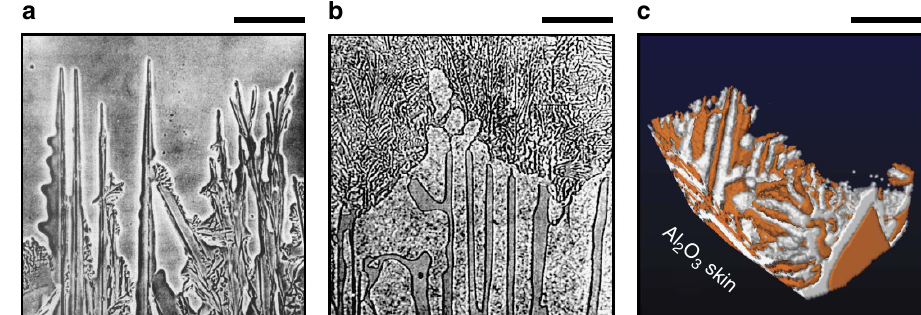
Figure 1 | Comparison of irregular eutectic growth morphologies. ( a ) Growth front of a eutectic mixture of borneol (faceted minor constituent) and succinonitrile 20 . Reproduced with permission from Wiley Verlag 20 . ( b ) Quenched growth front of an Al-12.7wt%Si eutectic, where an envelope of Al encloses the faceted Si crystals 6 . According to Hellawell, this metallic ‘skin’ could not have been present at temperature and must have formed during the quench 6 . Reproduced with permission from Elsevier 6 . ( c ) Growth front of an Al-51.6wt%Ge, this work. The eutectic grows from the Al 2 O 3 oxide skin (not pictured) into the melt. The solid–liquid interfaces in c share some semblance to that of ( a ) in that the faceted Ge phase (orange) leads at the growth front. Scale bar, 12 m m ( a ), 35 m m ( b ) and 40 m m ( c